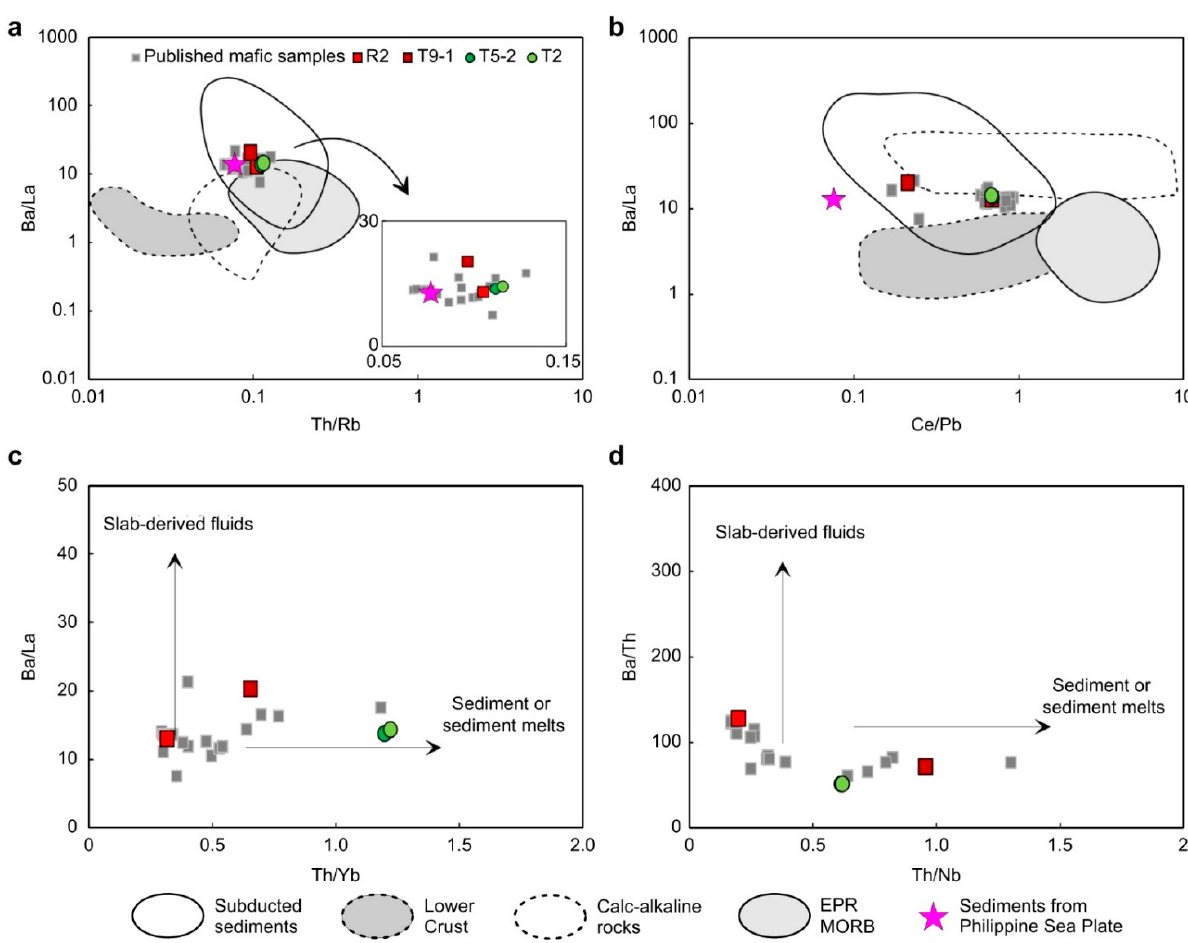
Figure 8. Trace element ratio plots: ( a ) Th/Rb vs. Ba/La, ( b ) Ce/Pb vs. Ba/La, ( c ) Th/Yb vs. Ba/La, and ( d ) Th/Nb vs. Ba/Th for the MOT and SOT volcanic lavas. Compositions of the EPR MORB data are from PetDB database (www.earthchem.org/petdb accessed on 10 December 2021). Subducted sediment compositions are from [10]. Canary ocean island basalt (OIB) contents are from [119]. Calc-alkaline basalt contents are from [120,121], and the values for the lower crust in the North China Craton are from [122]. Data for published mafic samples are from [1,36,50,74]. Data for published felsic samples from [1,73,74]. Data for samples R2, T5-2, T6-1, T2, and T6-2 in the MOT and T9-1 in the SOT are from this